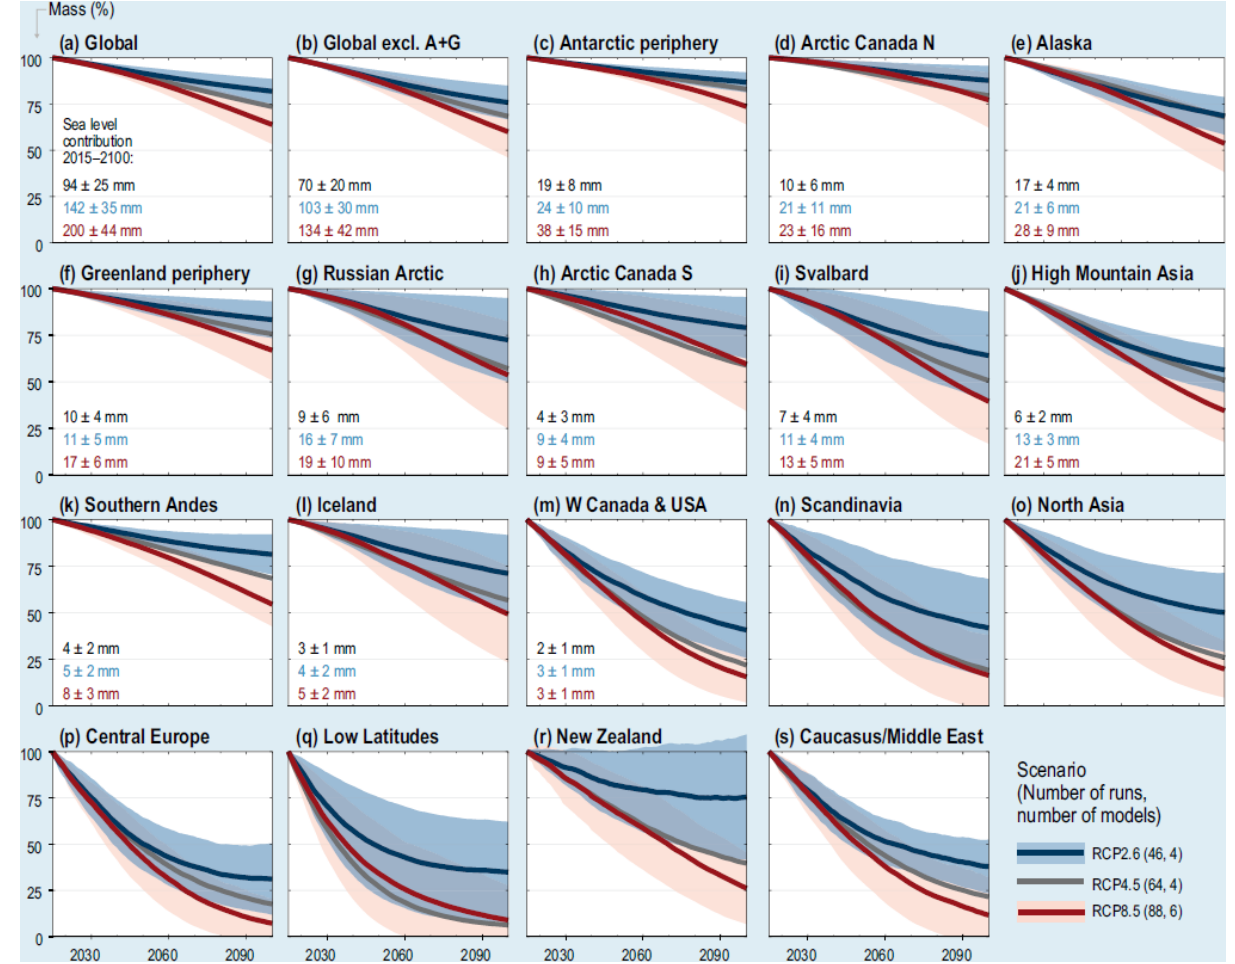
Figure 28. Mean projected glacier mass evolution between 2015 and 2100, relative to each region’s glacier mass in 2015 (in percent) and ± 1standard deviation under RCP2.6, RCP4.5, and RCP8.5. Source: Hock et al., 2019; see their figure